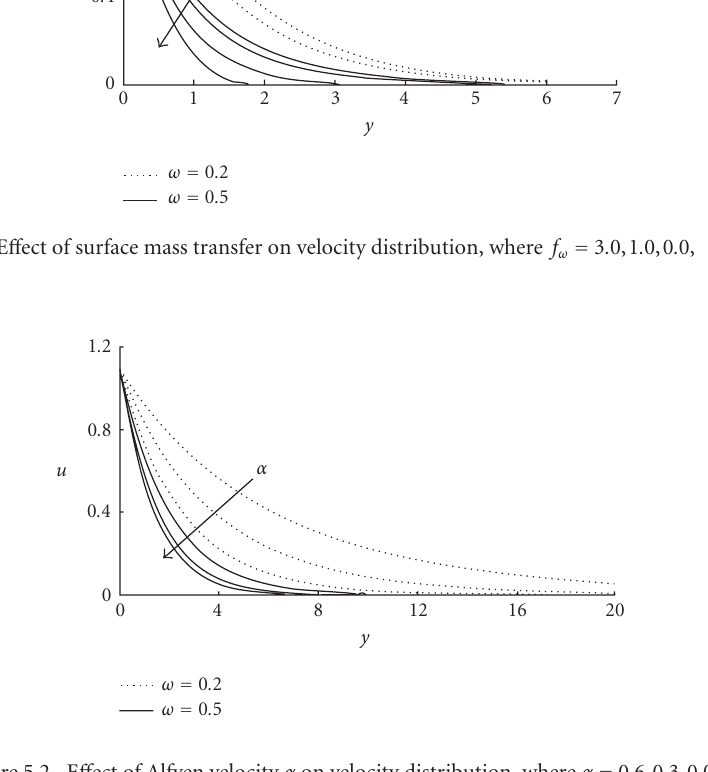
Figure 5.2. E ff ect of Alfven velocity α on velocity distribution, where α = 0 . 6,0 . 3,0 .